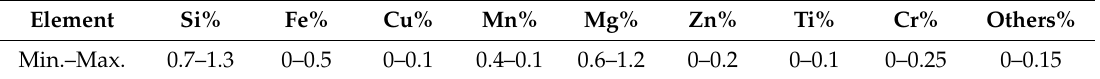
Table 3. Turning parameters have direct influence on the machined chips geometry. Chips geometry